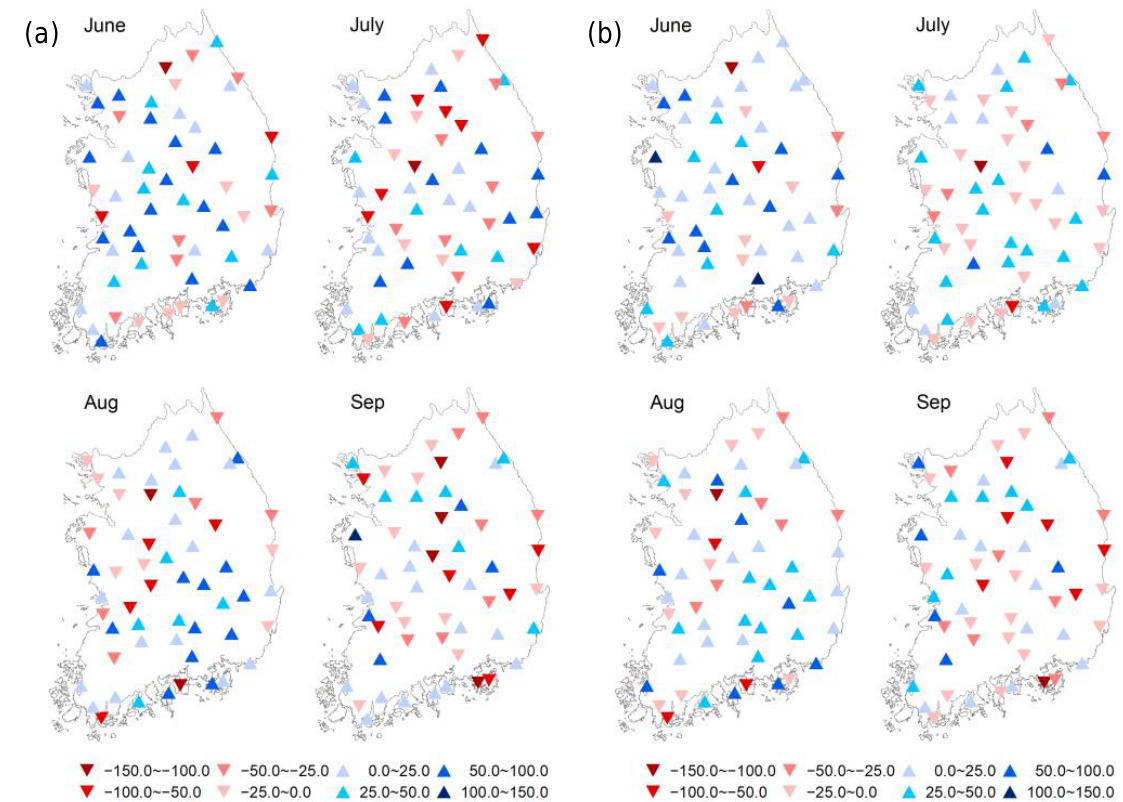
Figure 12. Mean deviation distribution of forecasts of EOF–ARIMA and CSEOF–ARIMA in June, July, August and September, ( a ) EOF–ARIMA forecasts mean deviation distribution, ( b ) CSEOF–ARIMA forecasts mean deviation distribution.